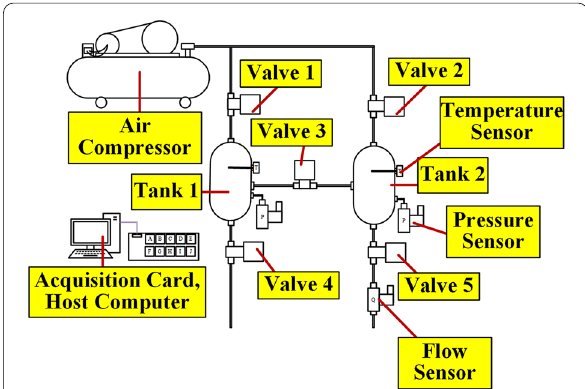
Figure 1 Schematic diagram of leakage measurement by differential pressure